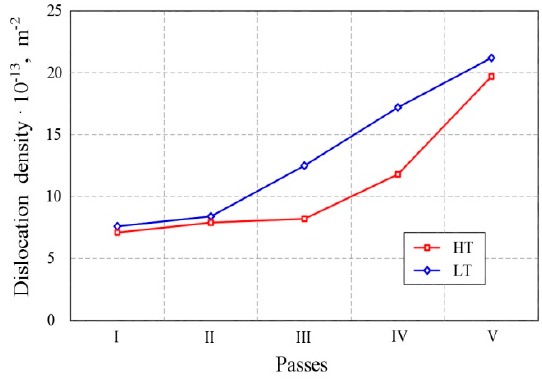
Figure 6. Change in the dislocation density by stages of final thermomechanical processing.